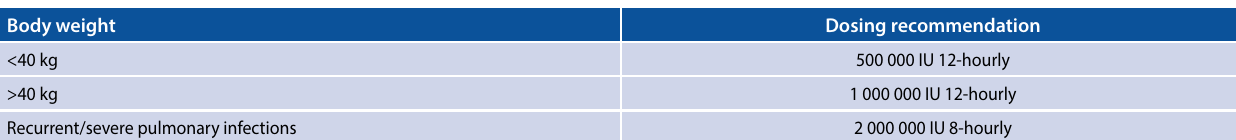
Table 5: The dosing of aerosolised colistin Body